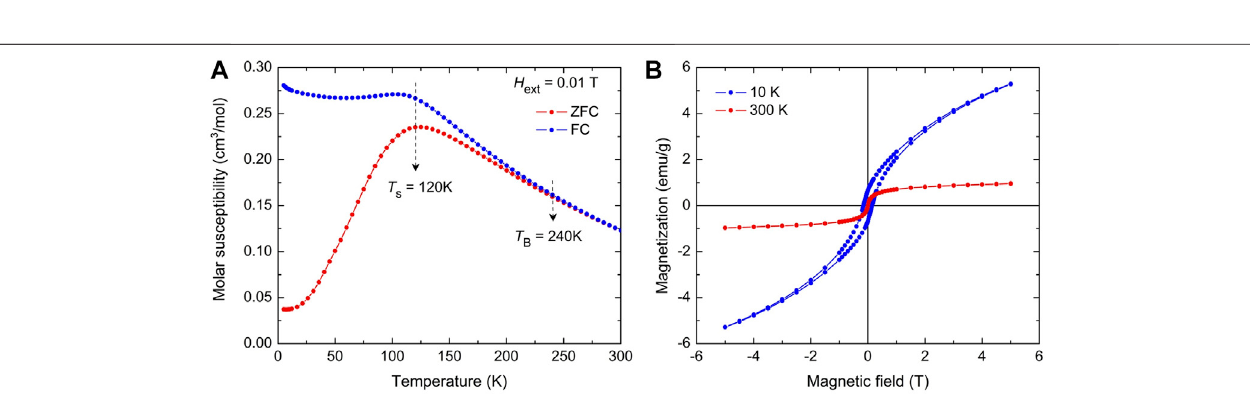
FIGURE7|(A) Zero- fi eld-cooled(ZFC)and fi eld-cooled(FC)magnetizationcurvesfortheas-preparedSr 2 FeMoO 6 takenatexternalmagnetic fi eld H ext =0.01 T. T s and T B denote blocking temperatures of the smallest and the biggest Sr 2 FeMoO 6 nanoparticles in the double perovskite particulate system, respectively. (B) Magnetization hysteresis loops for the as-prepared Sr 2 FeMoO 6 measured at 10 K (blue line) and 300 K (red line).